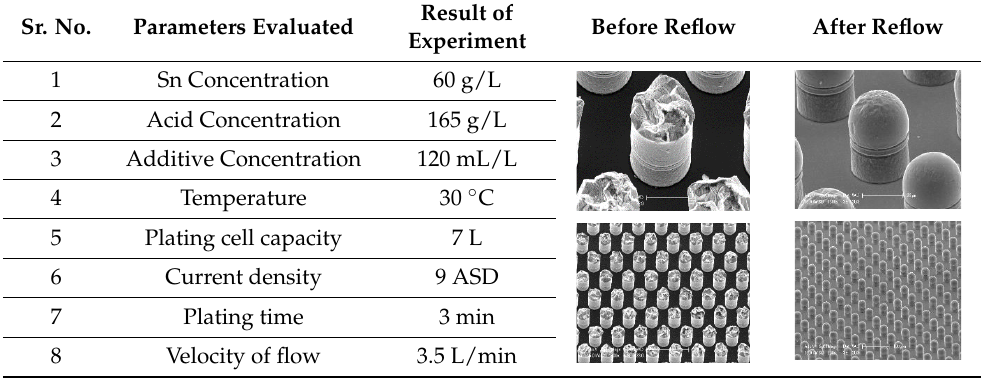
Table 6. Process conditions and images of microbump.